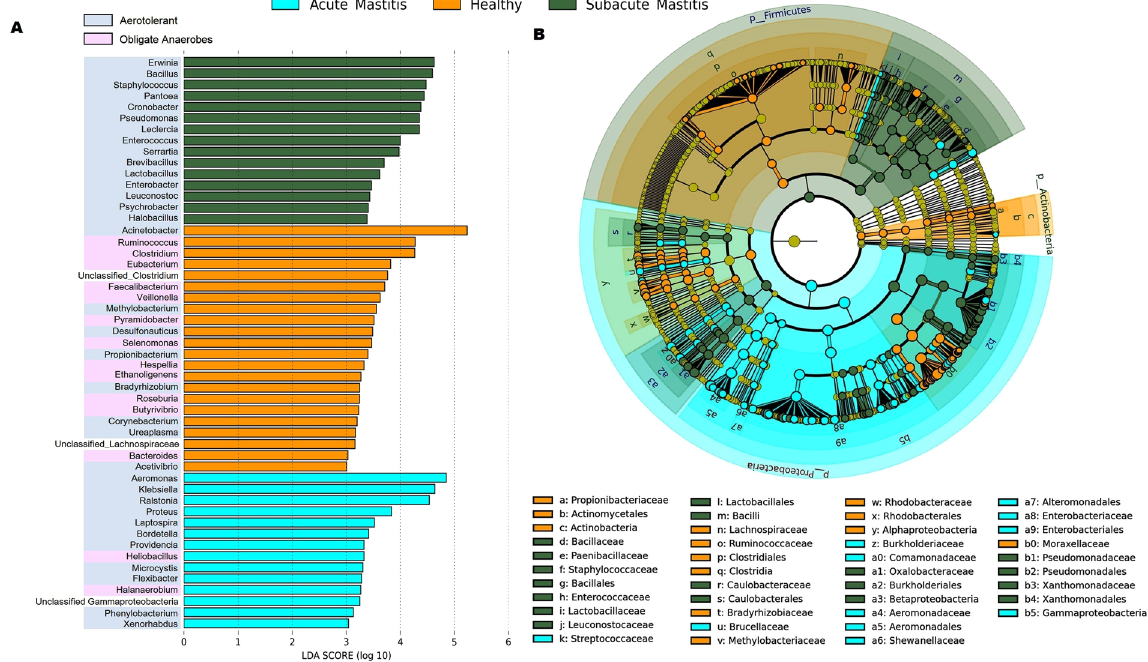
Figure 3. Differentially abundant bacterial taxa between healthy-controls, SAM and AM samples. ( A ) LEfSe was used to compare abundance of all bacterial genera between healthy-controls, SAM and AM samples. Significant bacterial genera were determined by Kruskal-Wallis test (P < 0.05) with LDA score greater than 3. ( B ) Cladogram representation of differentially abundant bacterial families detected using LEfSe. Different colors indicate the group in which clade was most